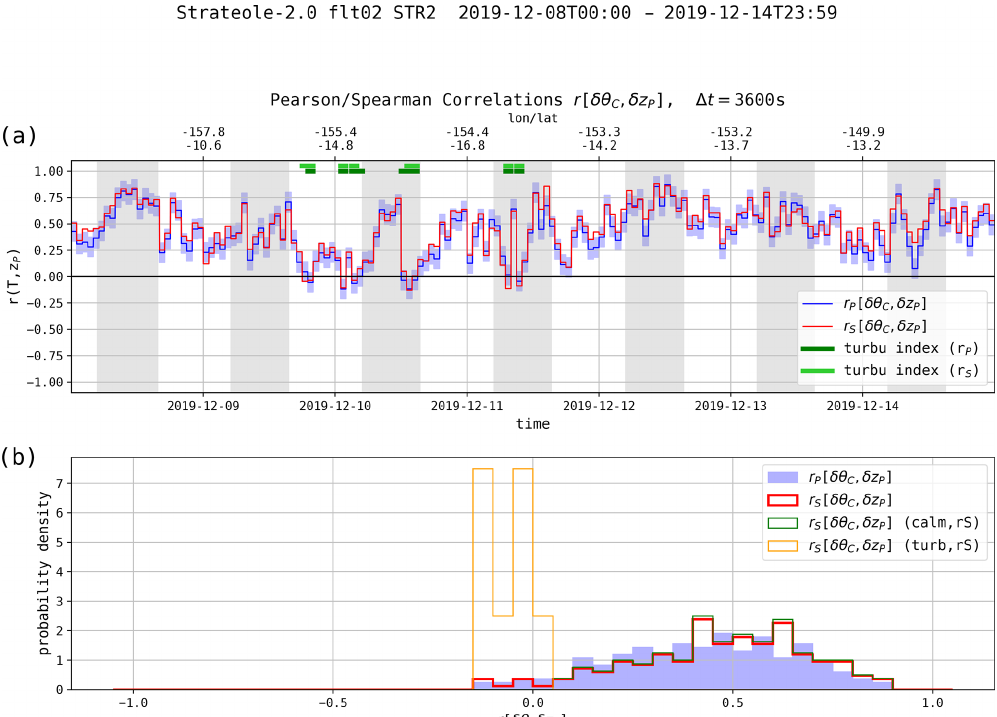
Figure 7. (a) Time series of correlation coefficients r P and r S applied to the increments’ potential temperature derived from T C and ver- tical displacements from z P . The correlations are evaluated on 1h time segments (120 samples). The time series runs for 7d, from 8 to 15 December 2019. The gray vertical stripes indicate nighttime. The light blue shaded areas show the ± 1 standard deviation interval for the Pearson correlations. (b) Histograms of the two correlation coefficients obtained during the week. The blue shading and thick red line correspond to all of the 1h time segments, and the thin green and orange lines correspond to the calm (nonturbulent) and turbulent time intervals,